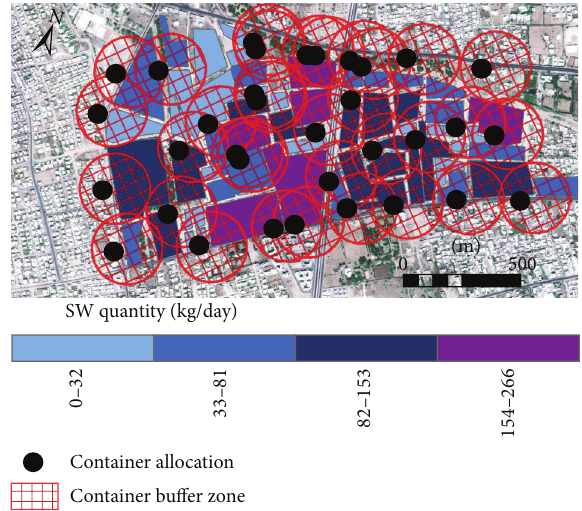
Figure 7: Quantity of waste produced by neighborhood and location of containers.